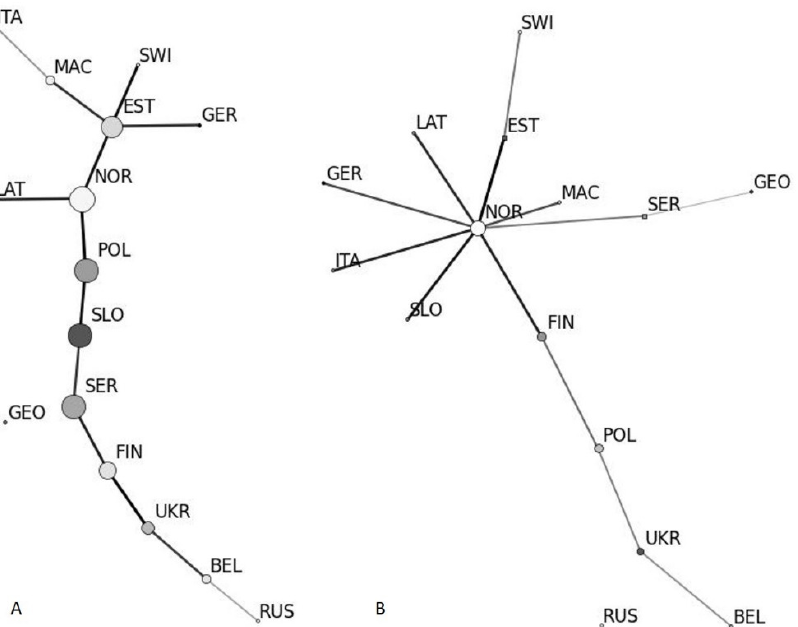
Figure 2. Minimum spanning network of D. sapinea subpopulations in Europe and western Asia based on the non-cc dataset ( A ) and cc-dataset ( B ). Darker node colour represents higher haplotype number in subpopulations and node size represents betweenness of subpopulation in the network. Darker edges represent a higher degree of connectivity. Subpopulations are coded as follows: Belarus—